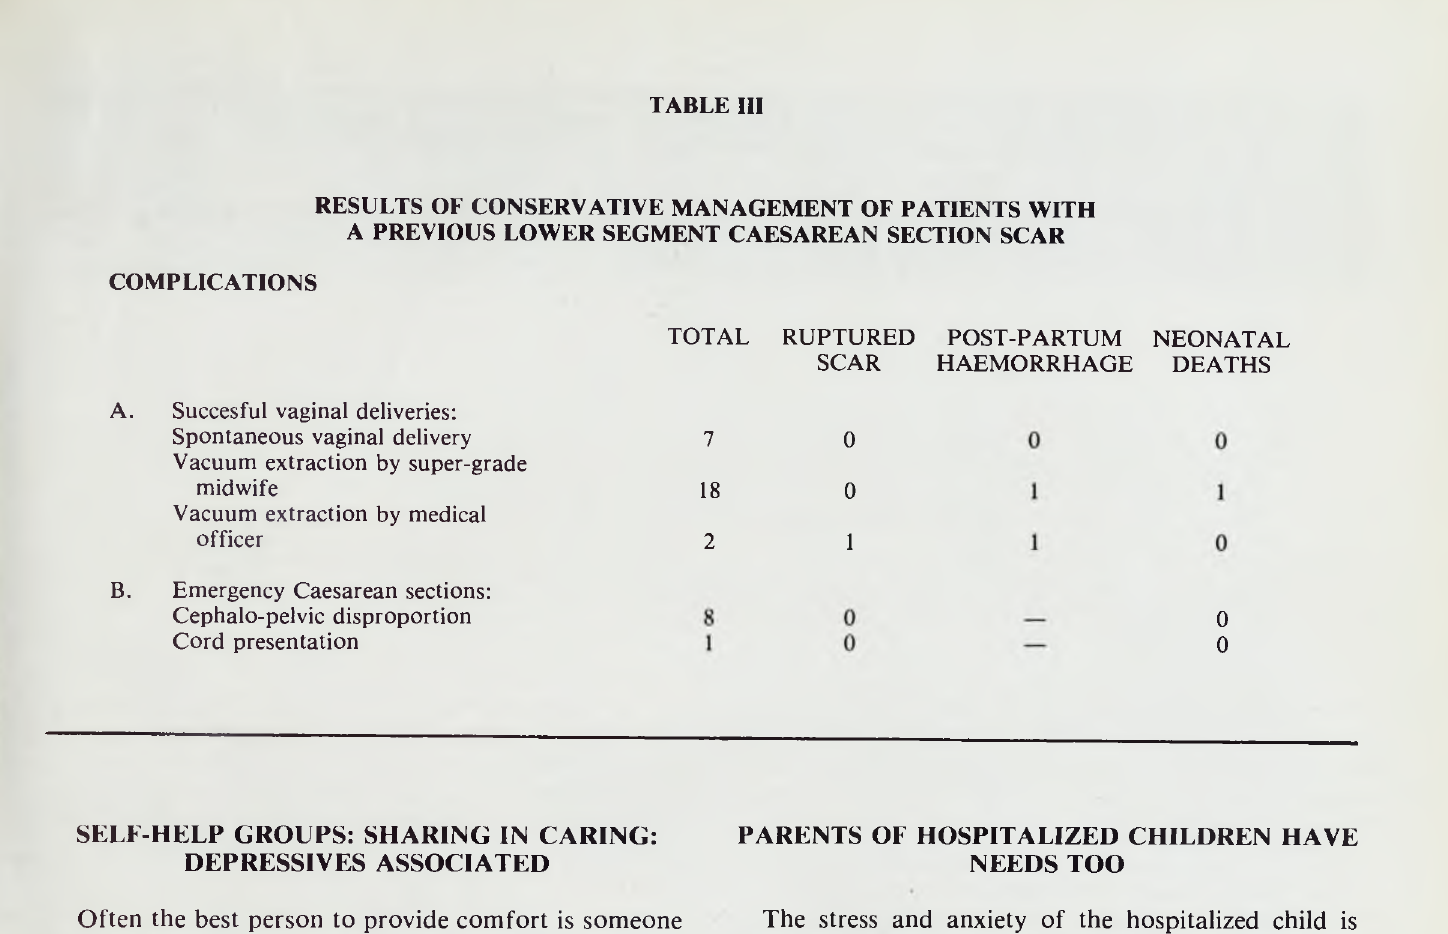
RESULTS OF CONSERVATIVE MANAGEMENT OF PATIENTS